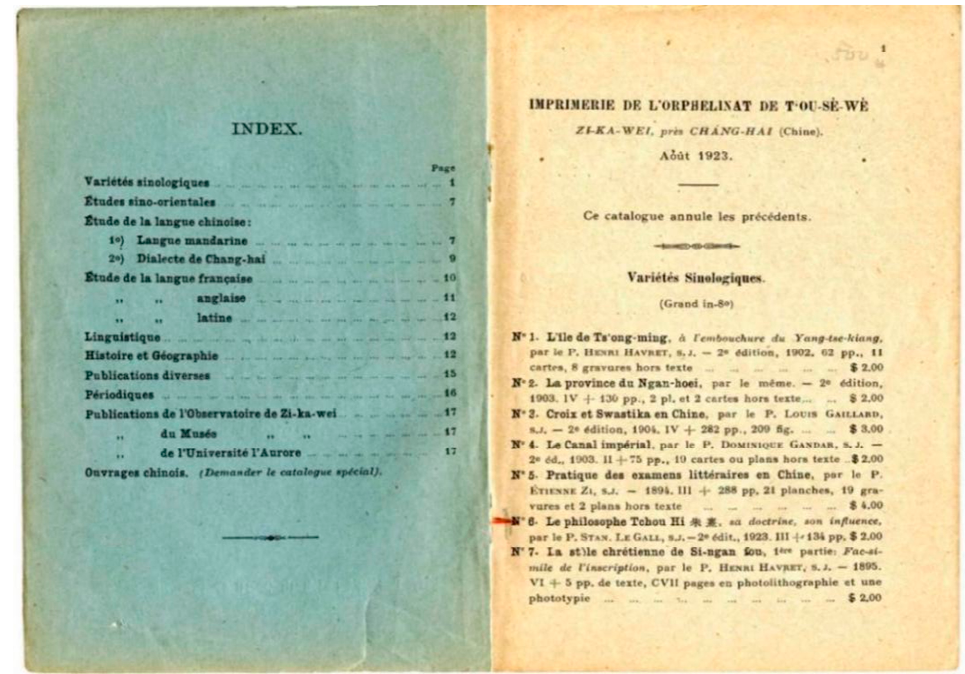
Figure 3. Catalogue of the Publications of the Plan Scientifique du Kiang-Nan 1923, Printed by Impr. de T’ou-sè-wè près Zi-ka-wei.